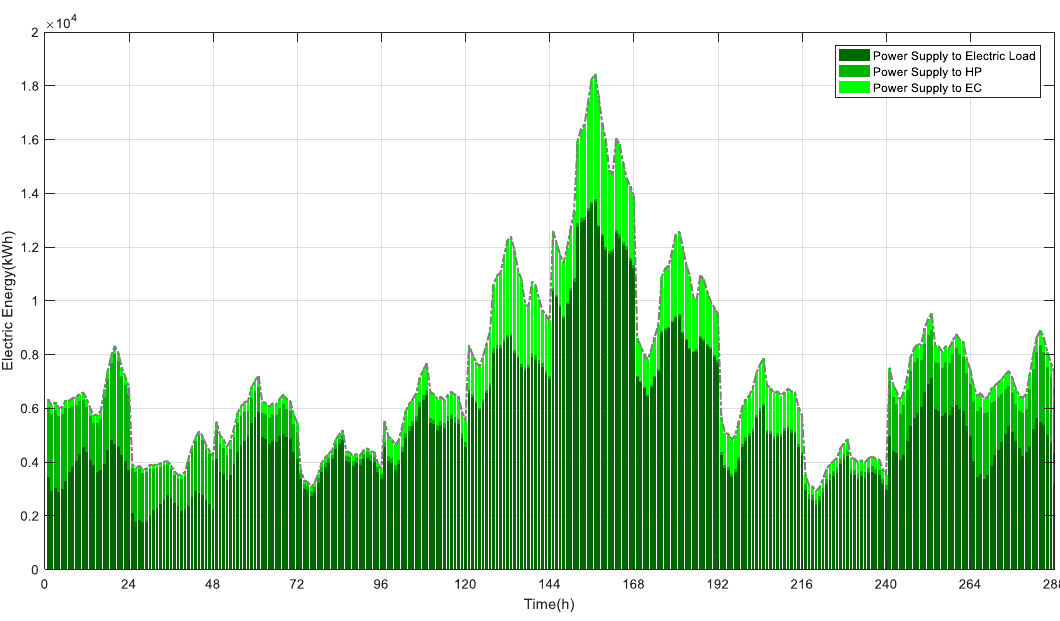
Figure 17. Diagram of daily-operation power distribution.